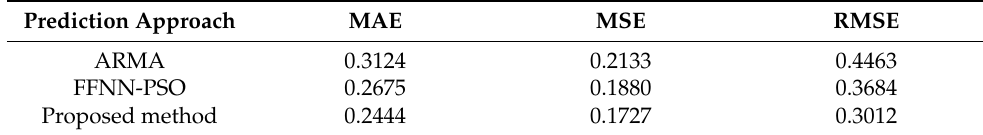
Figure 14. The error in samples prediction of the GHI, which is the difference between the proposed method’s output and the GHI’s actual values. Note that the samples are concentrated near 0, and the maximum error is less than 250 W . m 2 Table 2. Performance comparison between different